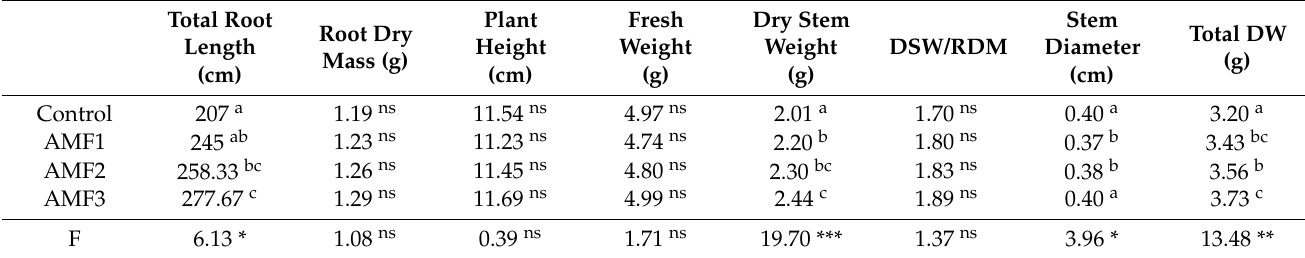
Figure 1. Percentage of AMF colonization derived from the three different treatments of AMF, 20 days after the emergence of the seedlings. F-test ratios are from ANOVA. Different letters (a, b, and c) over each curve indicate significant differences according to Tukey’s test ( p < 0.05). Table 1. Plant characteristics of aboveground and underground growth as affected by different treatments of